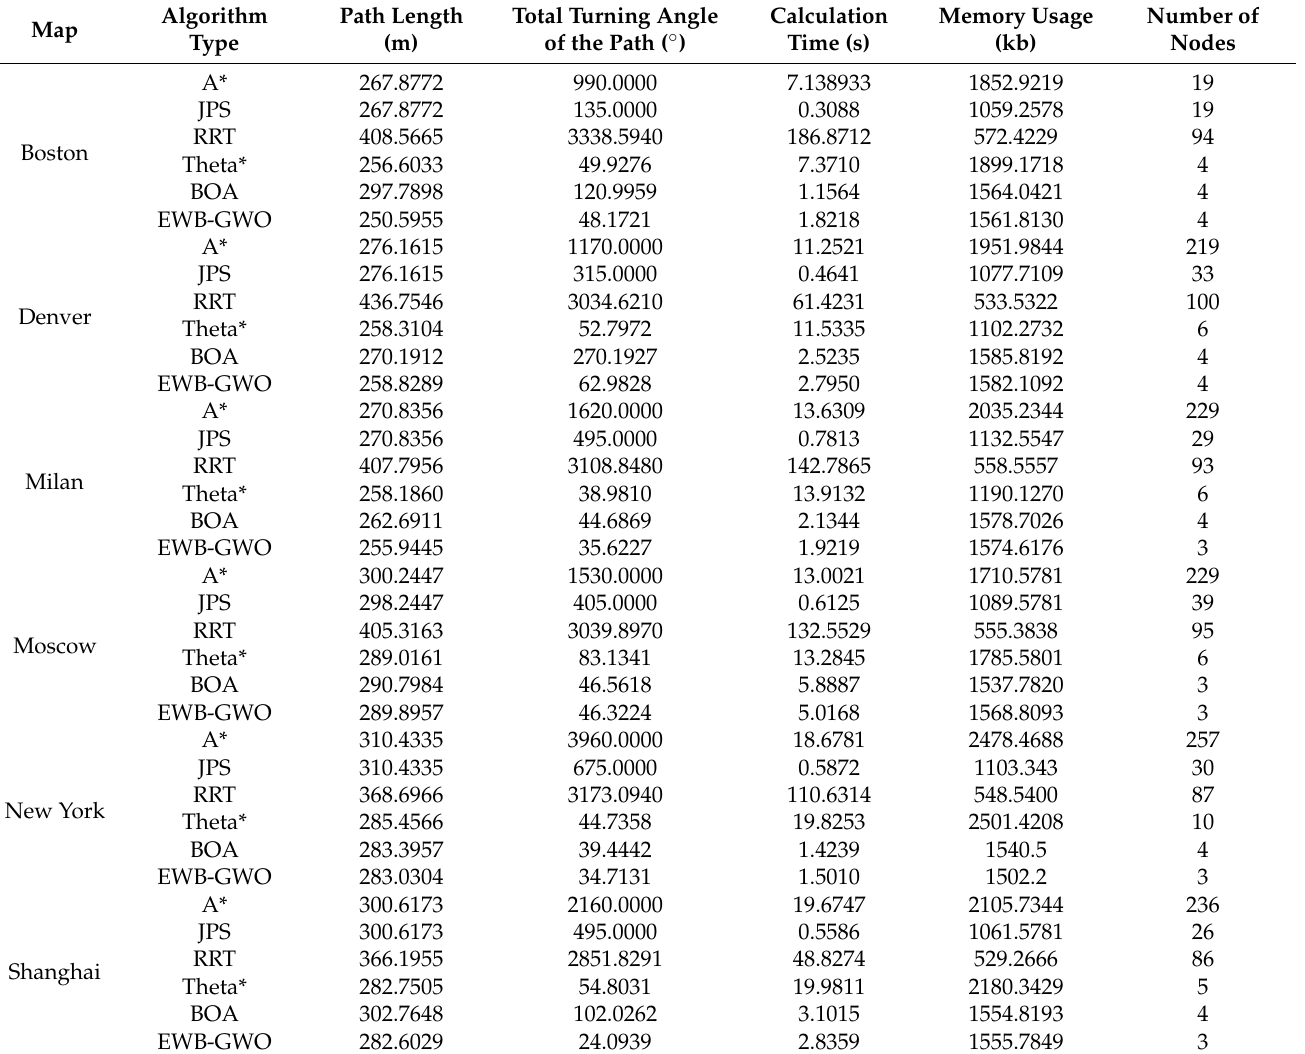
Table 11. Experimental results of path planning under city